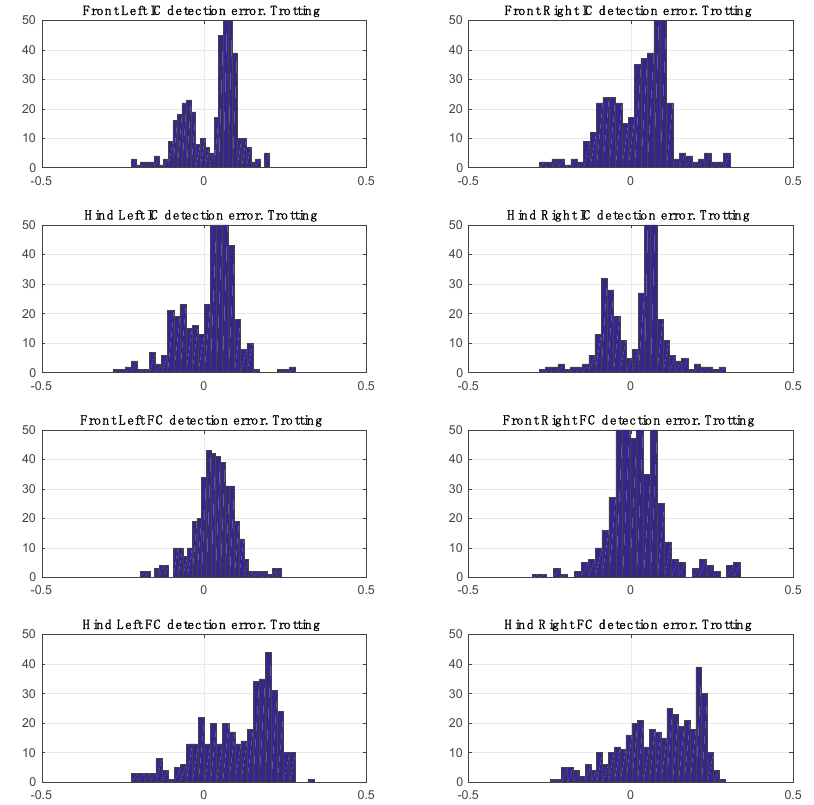
Figure 10 . Disagreement between predictions and annotations during trotting. Figure 10. Disagreement between predictions and annotations during